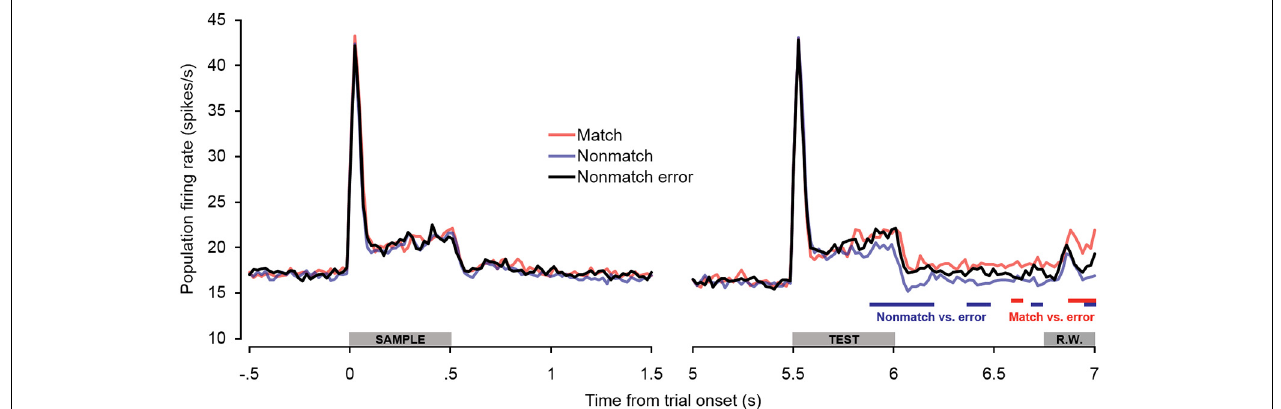
FIGURE 7 | Population spiking activity observed on error trials during auditory short-term memory task. Firing rates elicited by sample and test stimuli are depicted in the left and right panels, respectively. No significant differences in firing rate were observed for non-match error trials during pretrial baseline, the sample stimulus presentation period, or the retention interval. During the latter portion of the test stimulus period, firing rates on non-match error trials were significantly higher than on correct non-match trials (similar to match trials). During the cue offset and pre-response wait periods, firing rates